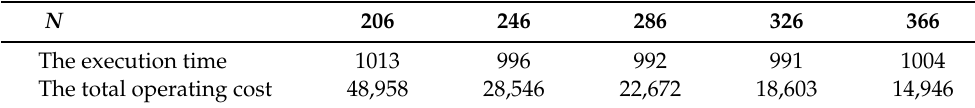
Table 4. The execution time and optimization results in case 1.